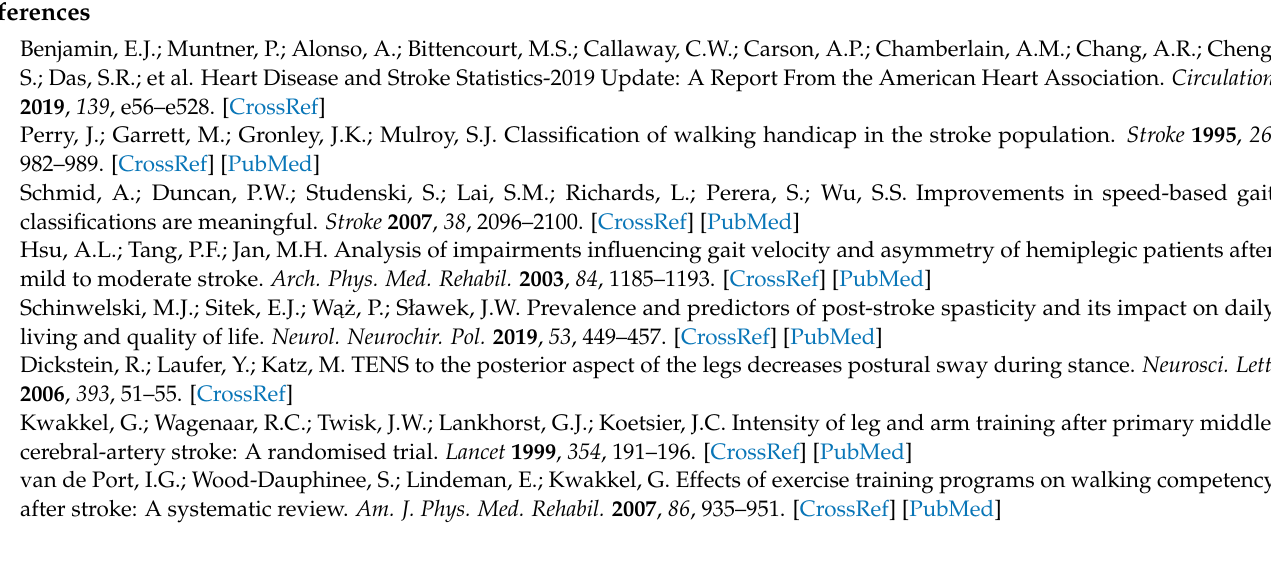
DTTRLM: dynamic tilt table with robotic leg